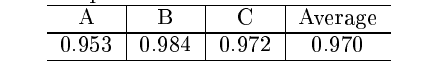
Table 1: IR transceiver speci(cid:28)cations